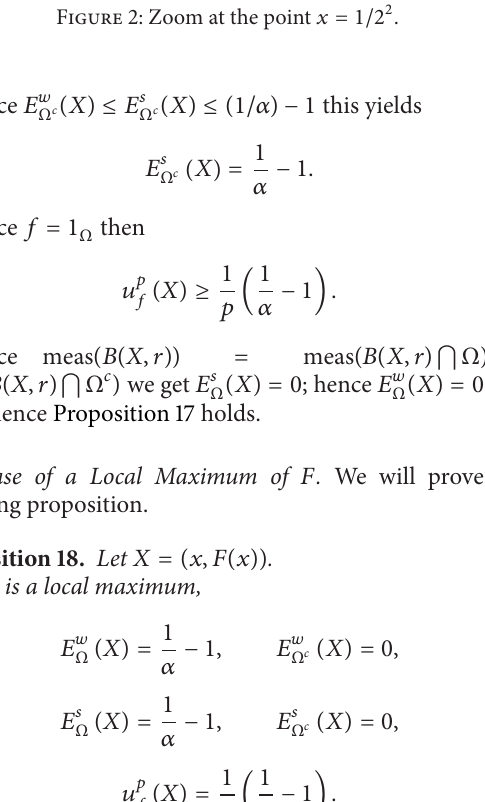
Figure 2: Zoom at the point 𝑥 = 1/2 2